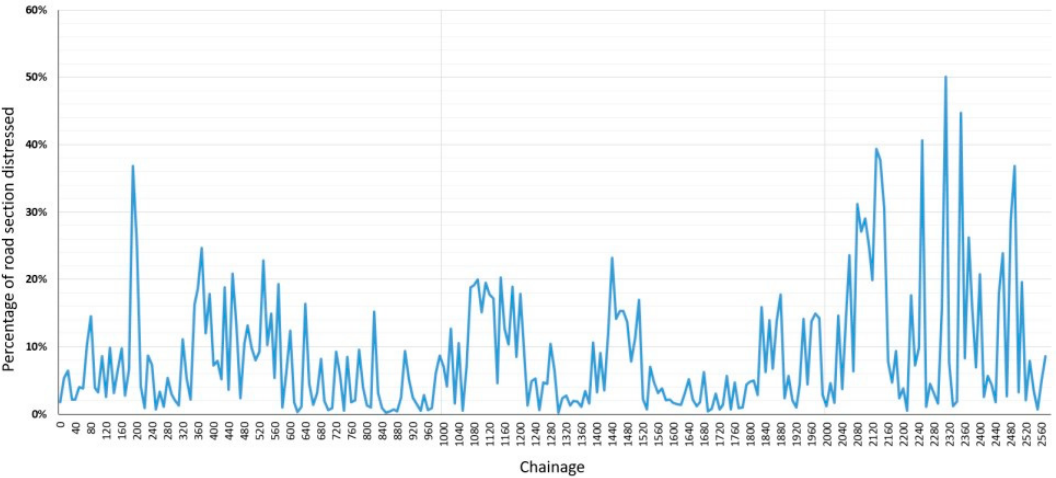
Figure 18. Level of the distress on the road across the test section.